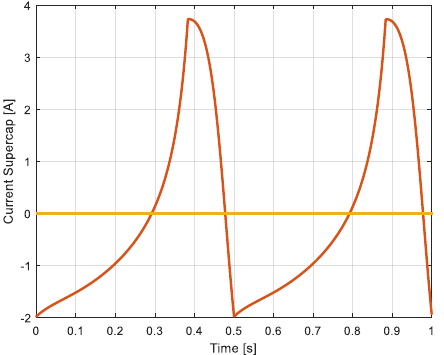
Figure 23. Current exchanged with the compensator capacitor(A).